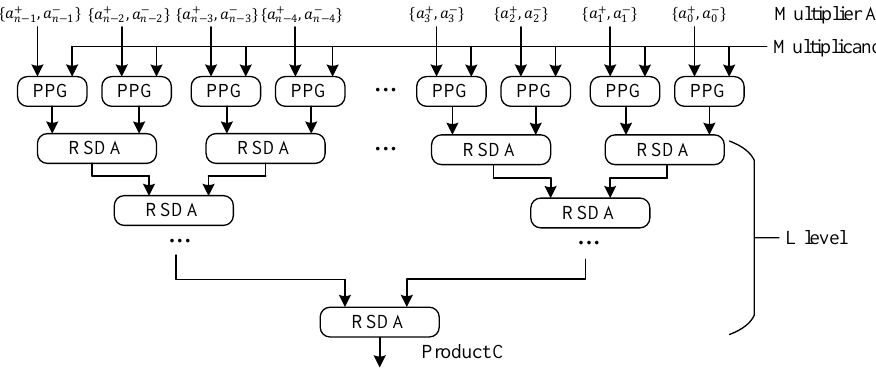
Figure 1: The block diagram of a RSD multiplier.